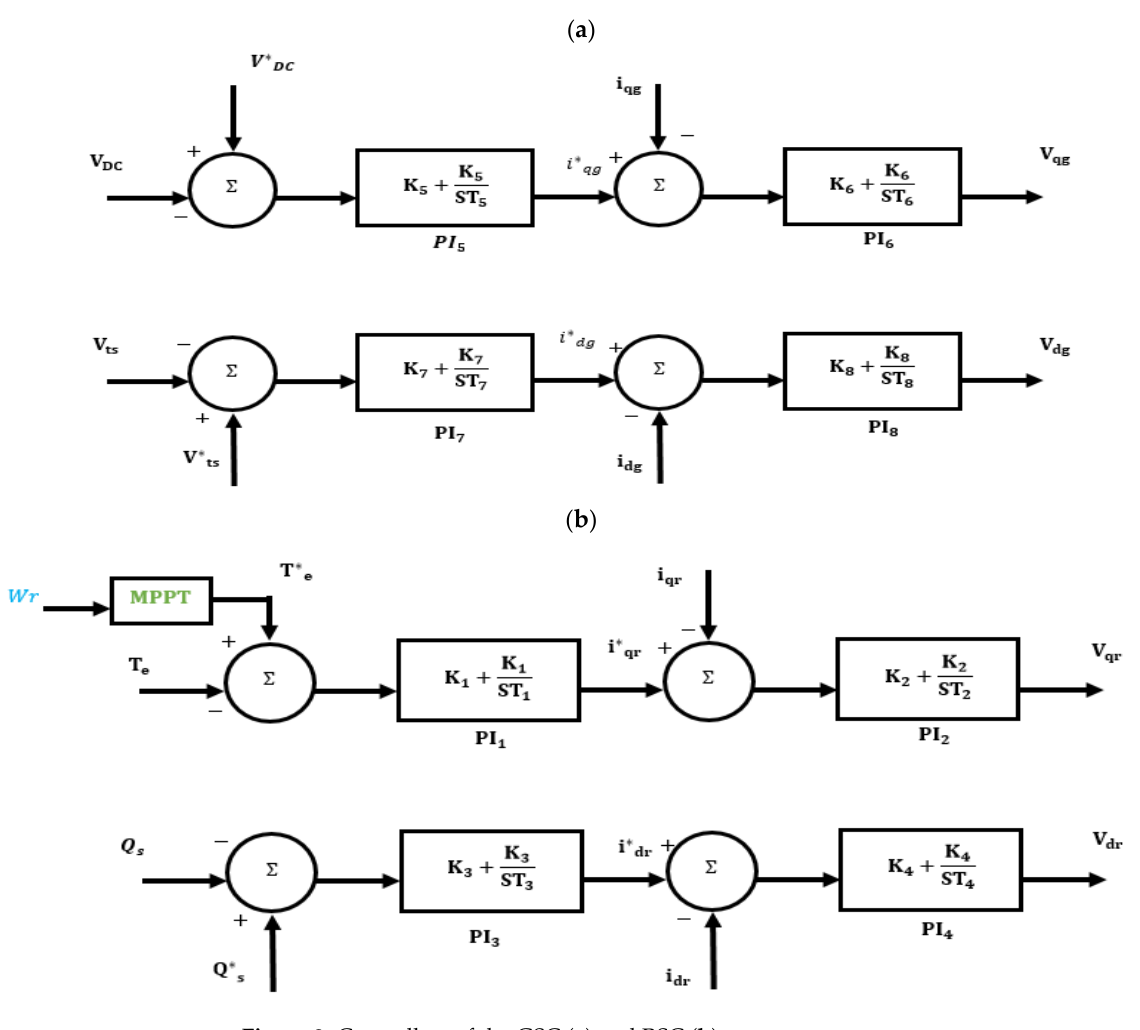
Figure 2. Controllers of the GSC ( a ) and RSC ( b ). Note that the RSC control loops regulate the electromagnetic torque (d-axis loop) and the generator reactive power (q-axis loop), whereas the GSC control loops regulate the DC-link voltage (q-loop) and terminal voltage (d-loop) by providing necessary reactive power [21].